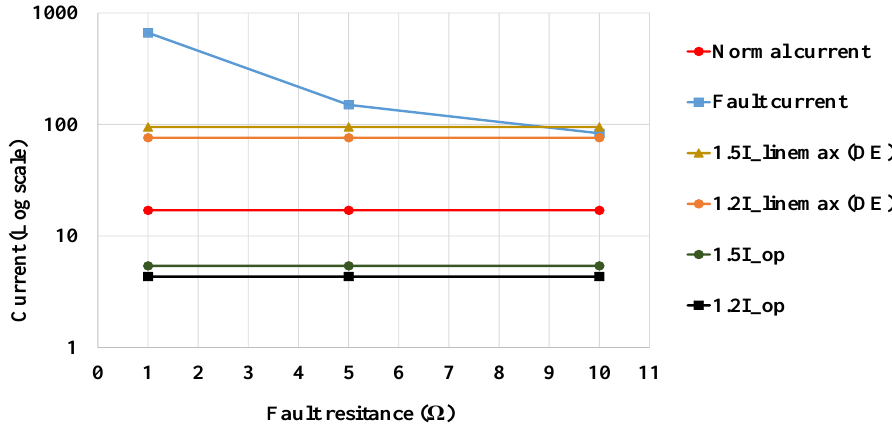
Figure 15. Fault condition with different fault resistances with 70% load and 95% of